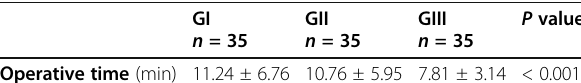
Table 2 Operative time in the studied